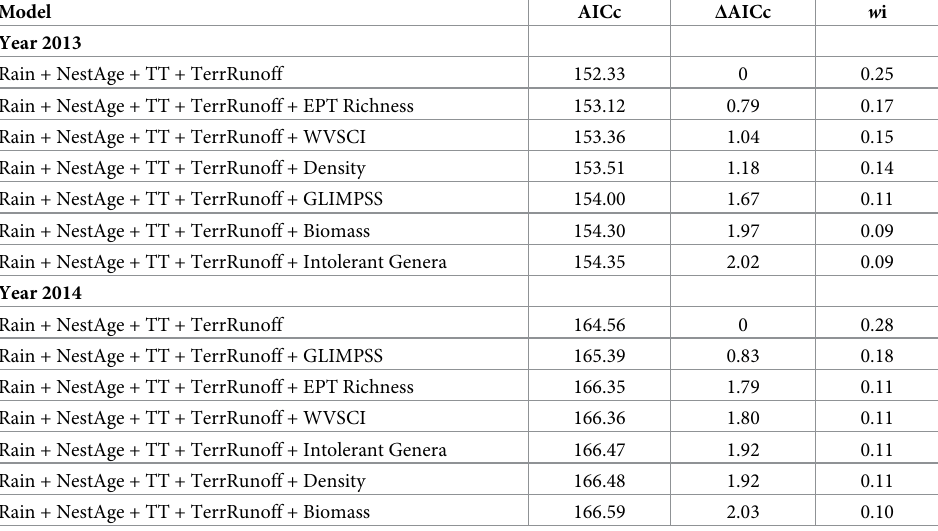
Table 5. Year 2013 and 2014 AICc model results of 7 a priori nest survival models with aquatic prey covariates using Program MARK. Of 7 a priori nest survival models, 6 different models were supported ( Δ AICc < 2) in 2013 and 2014 with the null base model having the most weight in both years (wi = 0.25, 0.28). Δ AICc = distance from the top model, and w i = Akaike weight. Variable names are defined in S2